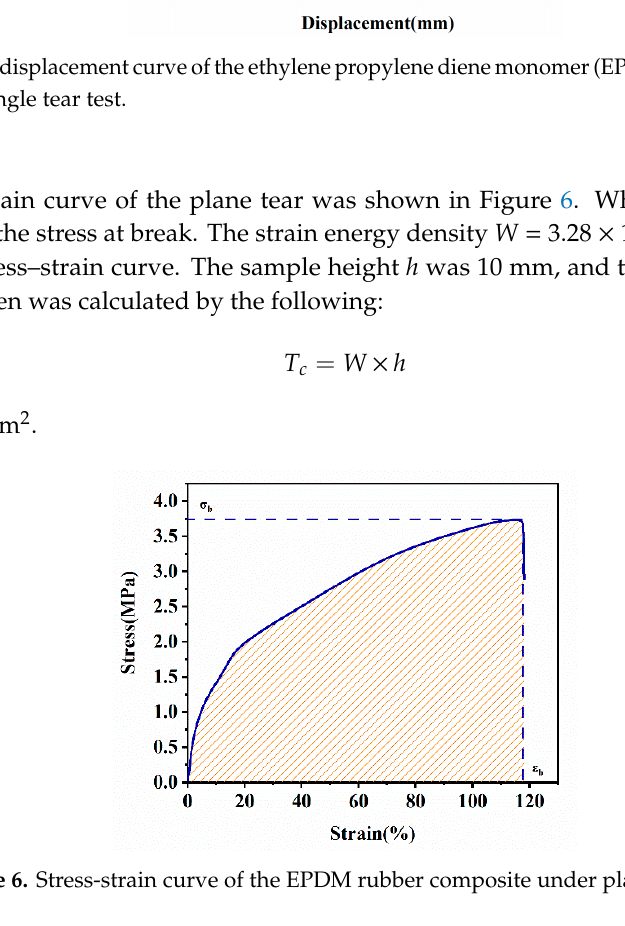
Figure 6. Stress-strain curve of the EPDM rubber composite under planar tension.